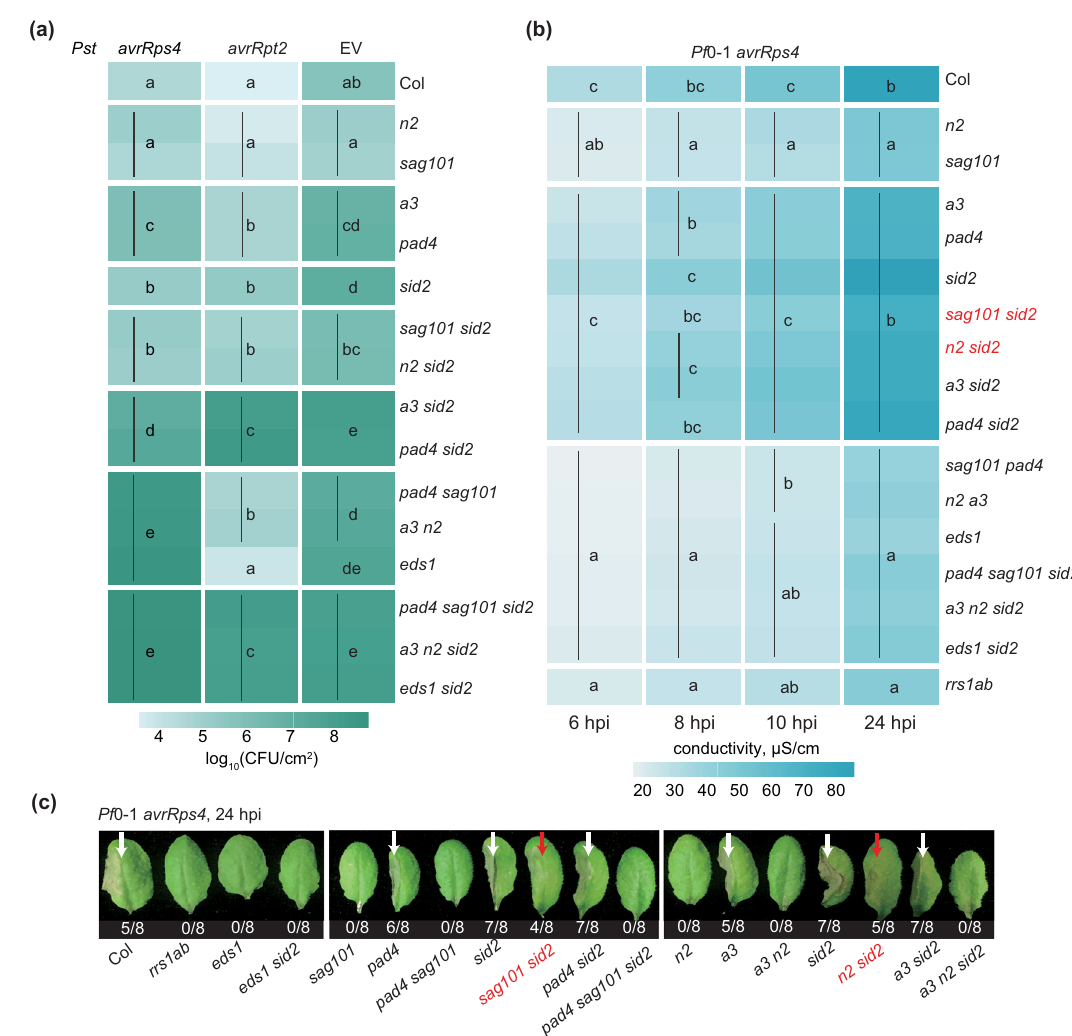
Fig. 2 Removal of the SAG101 – NRG1 and ICS1 sectors reveals PAD4 – ADR1 -promoted TNL cell death. a A heatmap representation of Pst avrRps4 , Pst avrRpt2 or Pst (empty vector, EV) growth at 3 dpi in leaves of indicated genotypes (syringe in fi ltration, OD 600 = 0.0005). The signi fi cance codes are